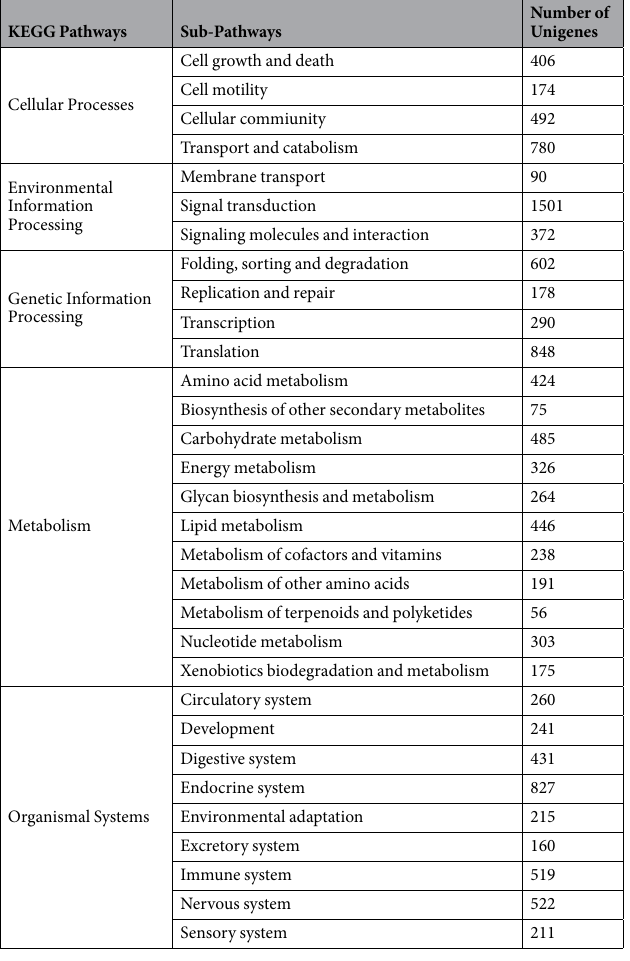
Table 4. Kyoto Encyclopedia of Genes and Genomes (KEGG) pathway mapping for R. philippinarum